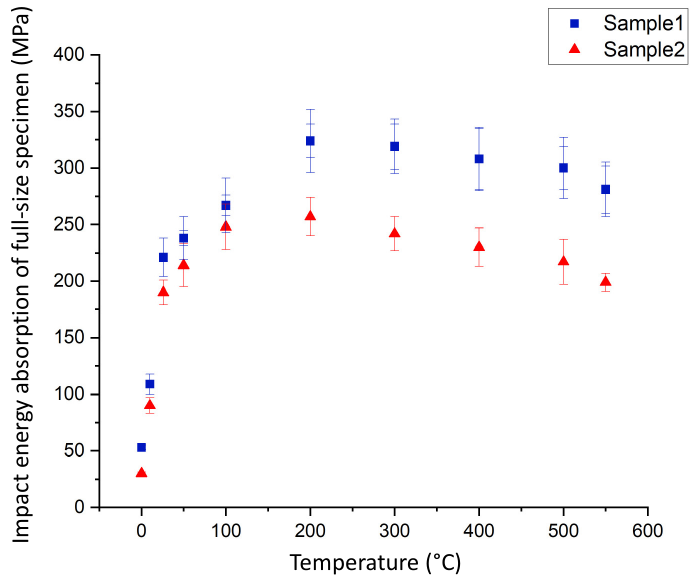
Figure 5. Impact test results of 12Cr1MoV steel from 0 °C to 550 °C.